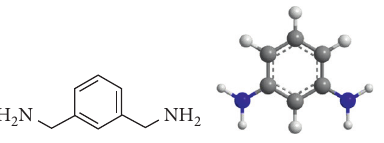
Figure 1: The structure formula of